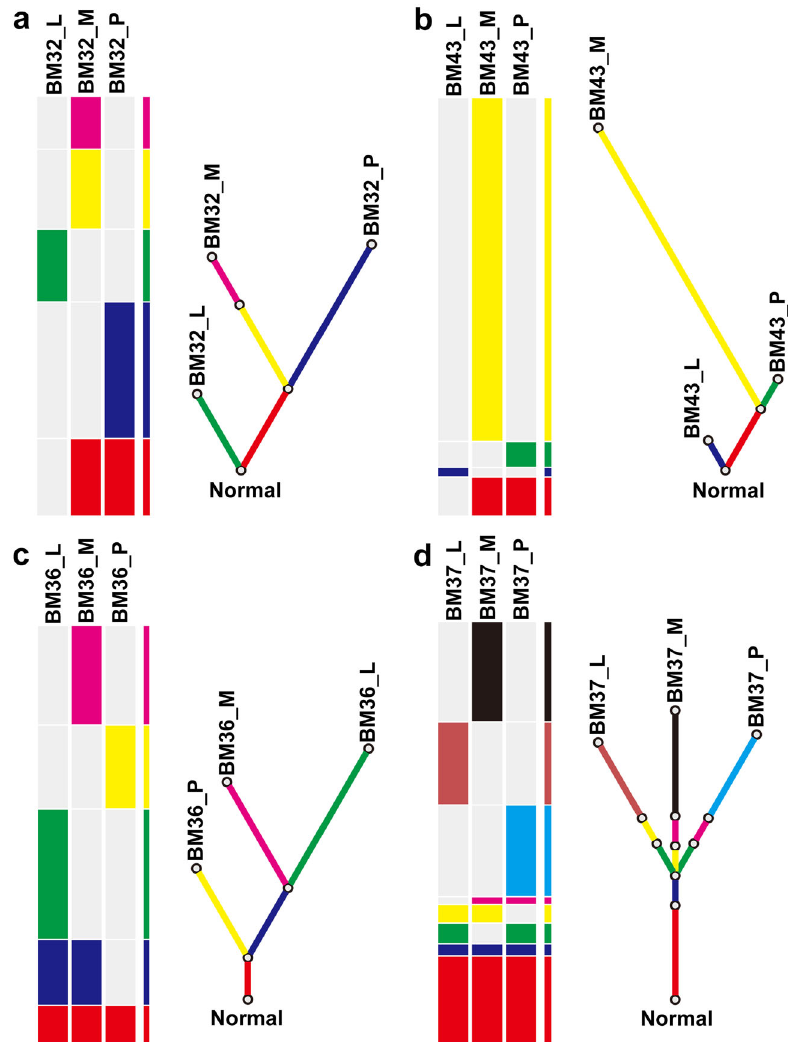
Fig. 4 Phylogenetic tree of four cases with synchronous lymphatic and brain metastases. a – d phylogenetic tree of BM32, BM43, BM36, and BM37. For each panel, heatplot with different bars represents various distributions of identi fi ed mutations including somatic SNVs and CNVs. Fraction of ubiquitous identi fi ed mutations (trunk) and unique identi fi ed mutations (branch) reveal the phylogenetic relationship of BM_P, BM_L and BM_M within a single case. BM_P primary lesion, BM_L lymph node metastasis, BM_M brain metastatic